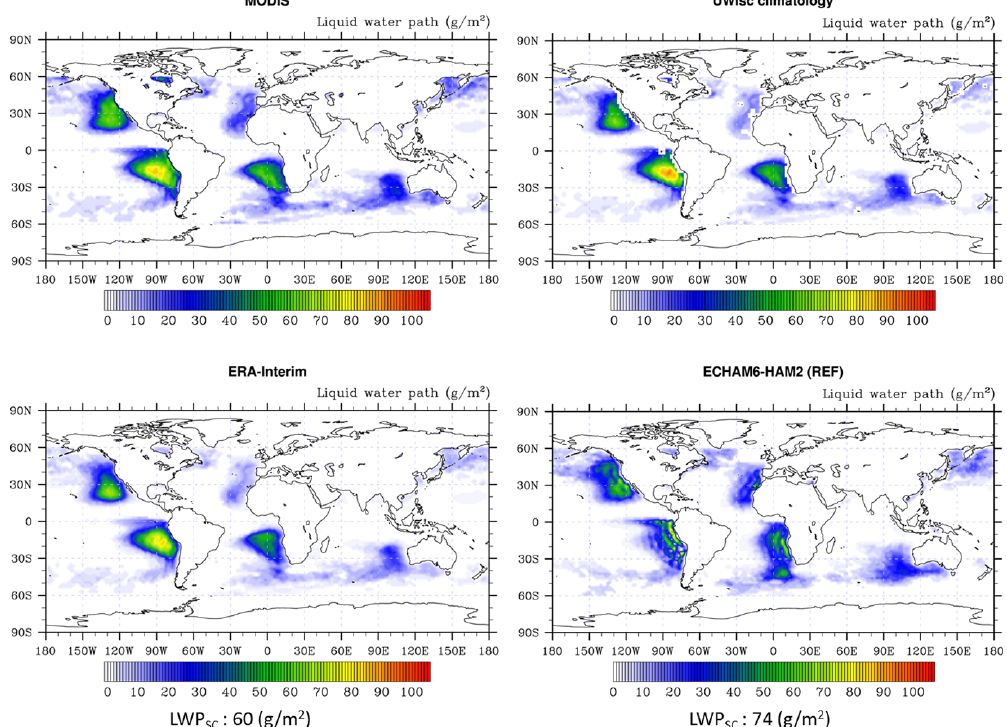
Figure 6. Liquid water path in stratocumulus cloud regions in the reference simulation, MODIS, ERA-Interim and a climatology from the University of Wisconsin. Values below the panels are in-regime